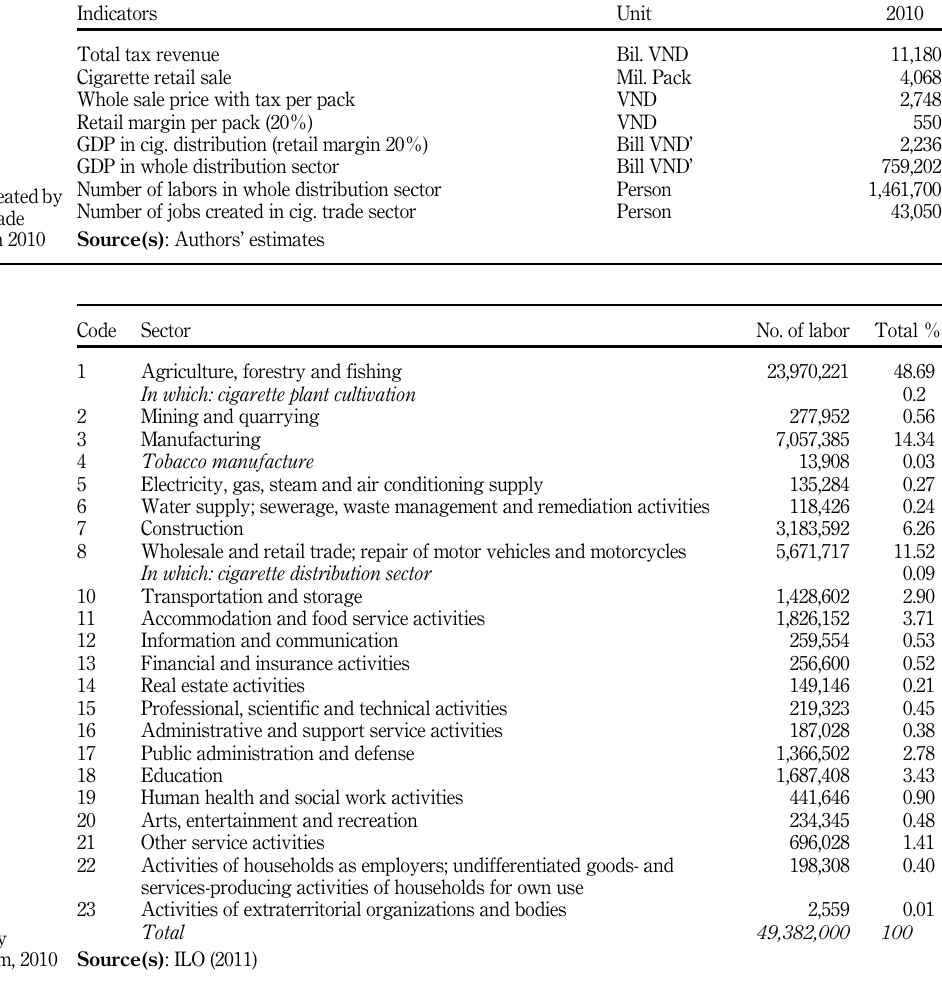
sectors, Vietnam,